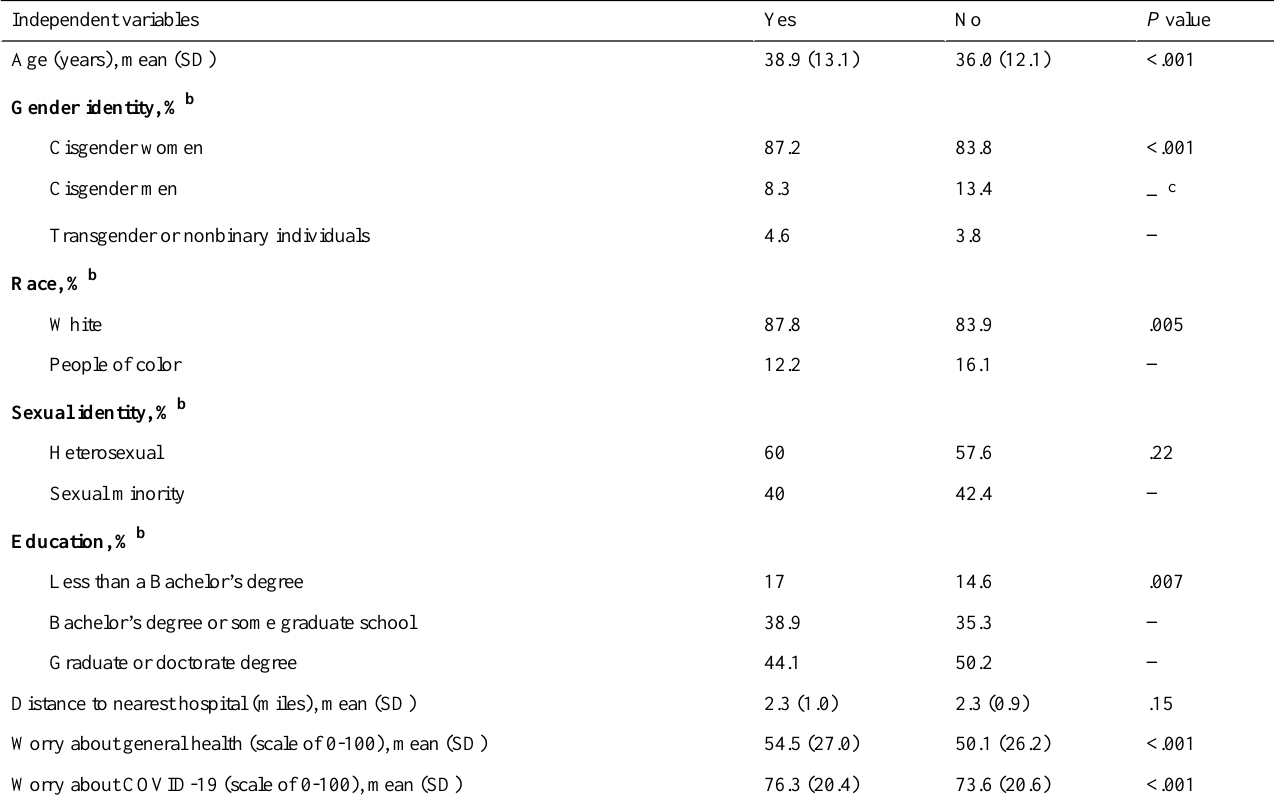
Table 3. Bivariate analyses a of the reasons for experiencing health care delays resulting from the COVID-19 pandemic (N=2570).